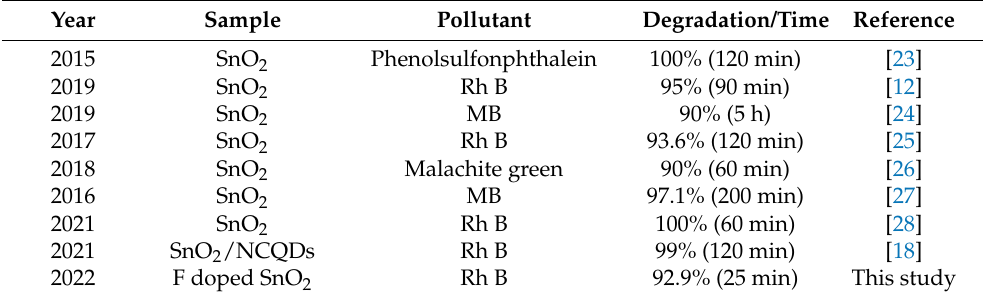
Table 3. Comparison of the photocatalytic degradation efficiency of SnO 2 nanoparticles.